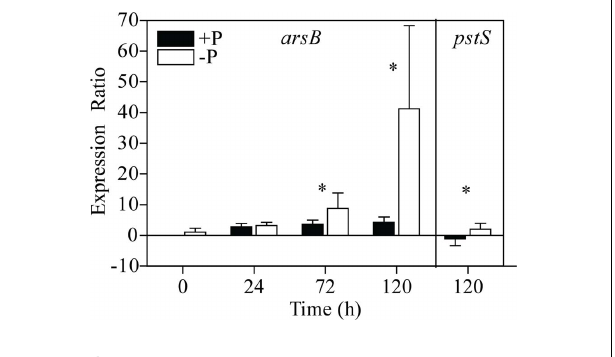
FIGURE 4 | Nitrogenase activity of C. watsonii WH8501 normalized to the control with no added arsenate. Treatments consisted of different concentrations of added arsenate as indicated. Error bars indicate the SE of the mean ( n = 3).